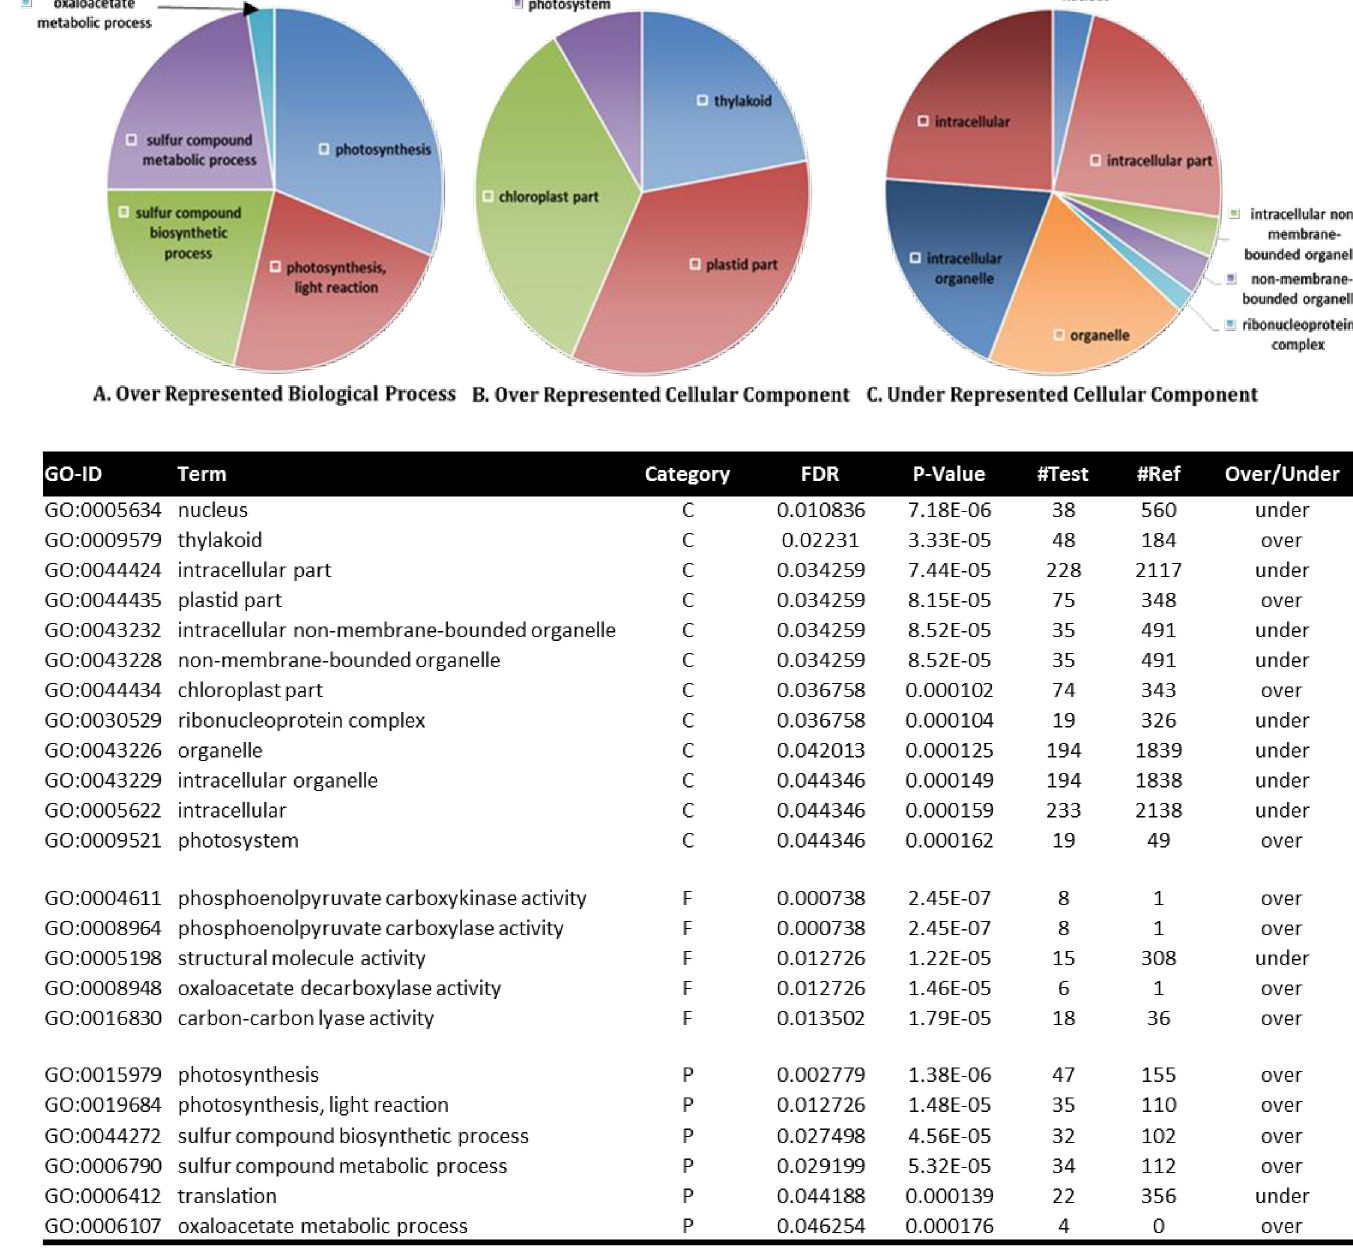
Fig 4. Gene Ontology Fisher’s Blast2GO analysis and queried with fruit tissues. A. Biological Process gene ontology terms over represented in the ORG treatment compared to CONV treatment. B . Over represented Cellular Components in the ORG treatment versus the CONV treatment. C. Cellular Component ontology terms under represented in the ORG treatment compared to the CONV treatment. Size of slices represent ratio of numbers of contigs to total number of contigs in the represented categories.